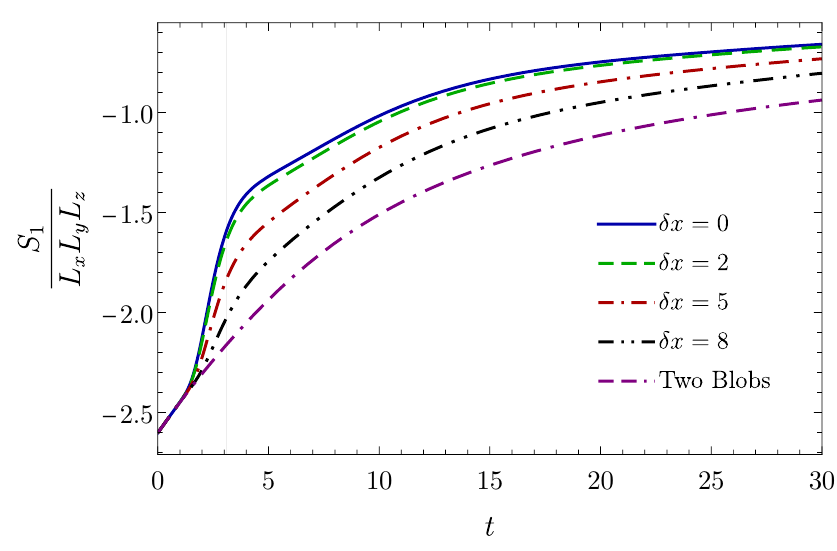
Figure 14 . Total entropy normalized by the volume as a function of time for identical initial data with different impact parameters. The vertical gray line indicates the collision time. As a reference, the entropy for the motion of two non-colliding blobs is